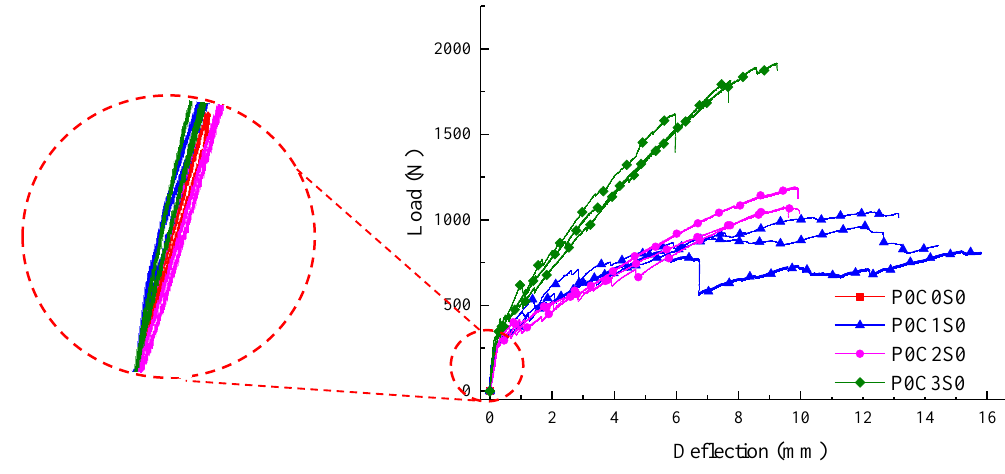
Figure 7. Load-deflection curves of the TRC specimens with different number of textile layers.